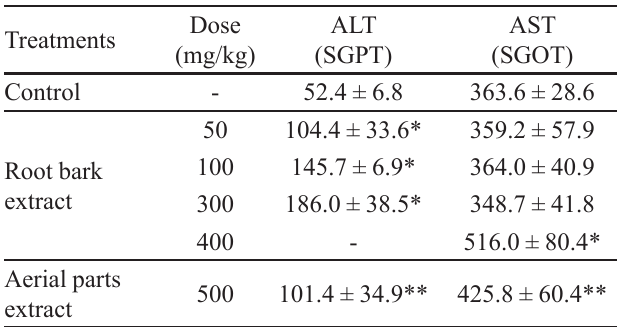
Values are expressed as mean ± standard deviation. N = 4-10.